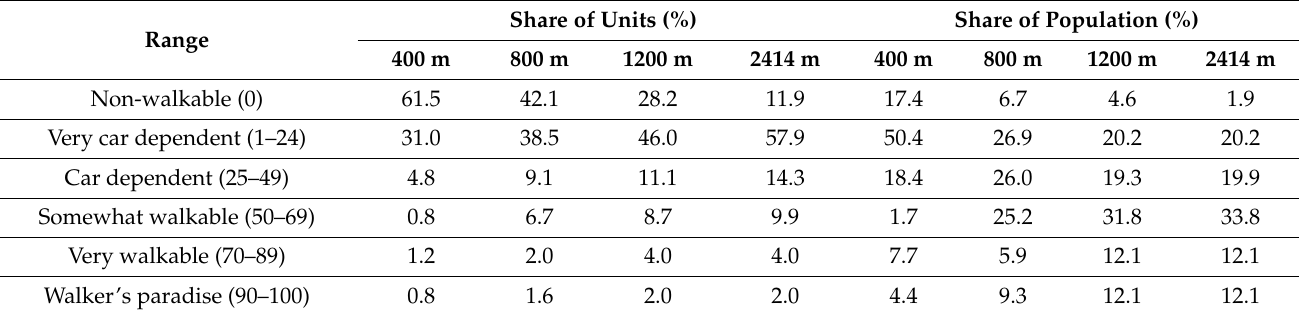
Table 4. Distribution of WS for different search radii in Hradec Kralove.